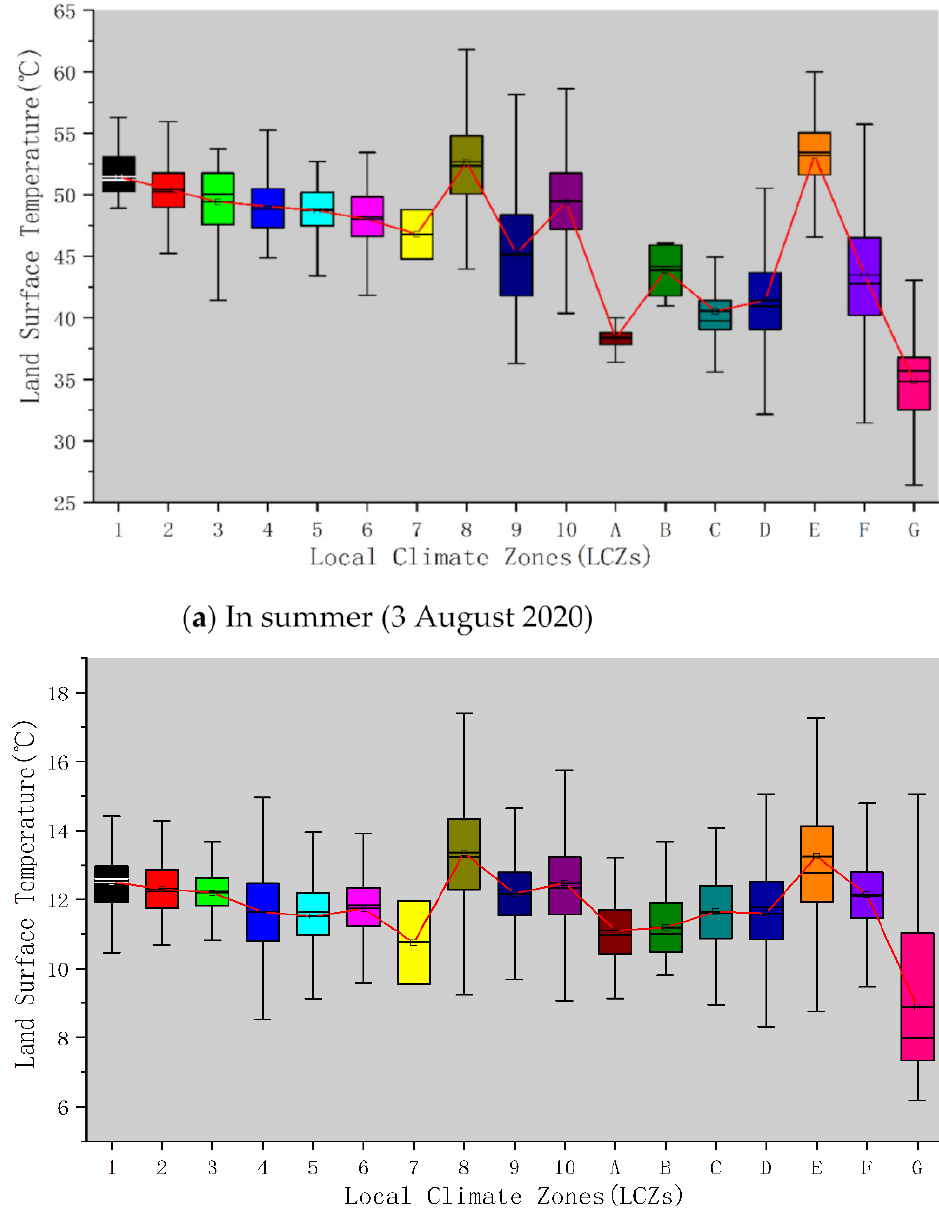
Figure 6. Mean LST of each LCZ class in Wuhan in ( a ) summer and ( b ) winter.